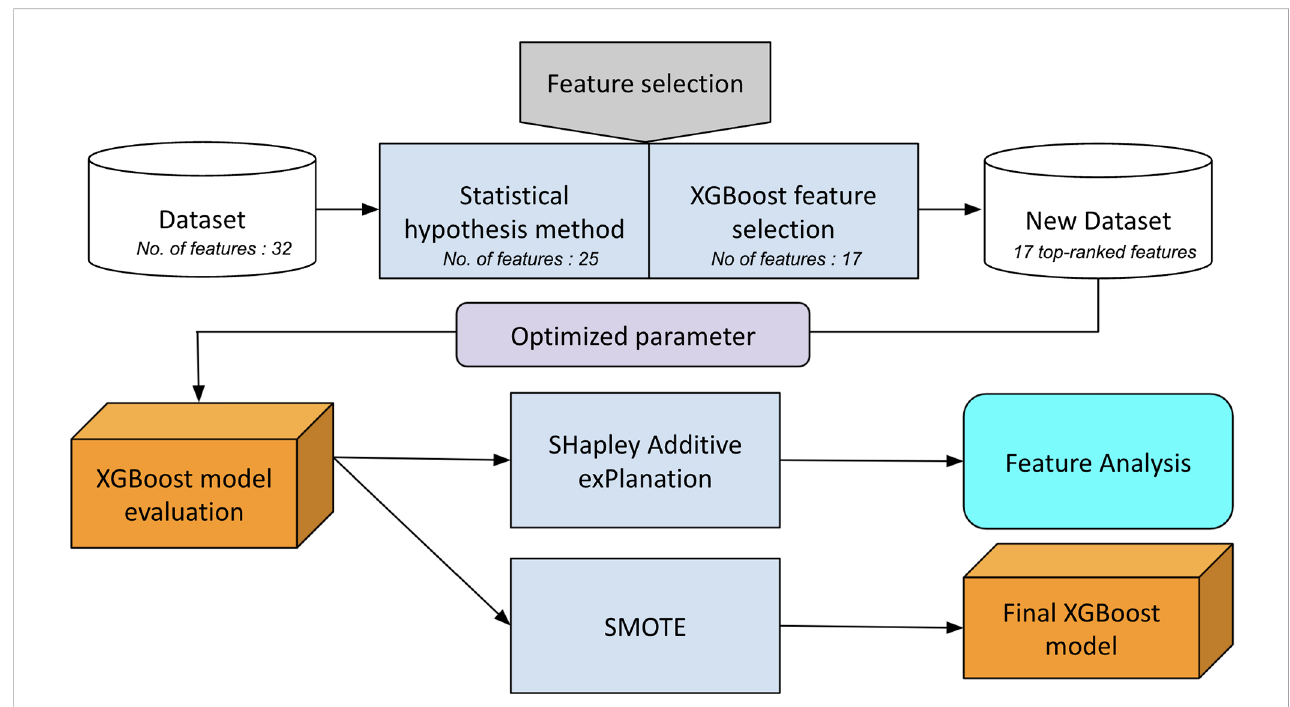
FIGURE 2 Flow chart of the hybrid feature selection to construct the fi nal XGBoost predictive